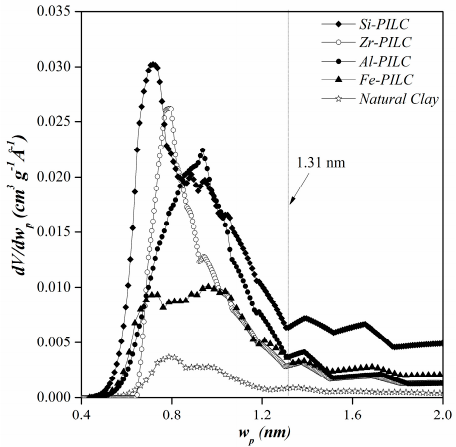
Figure 3. Pore side distribution of natural and pillared clay minerals where V is adsorbed volume and w p is the pore size.